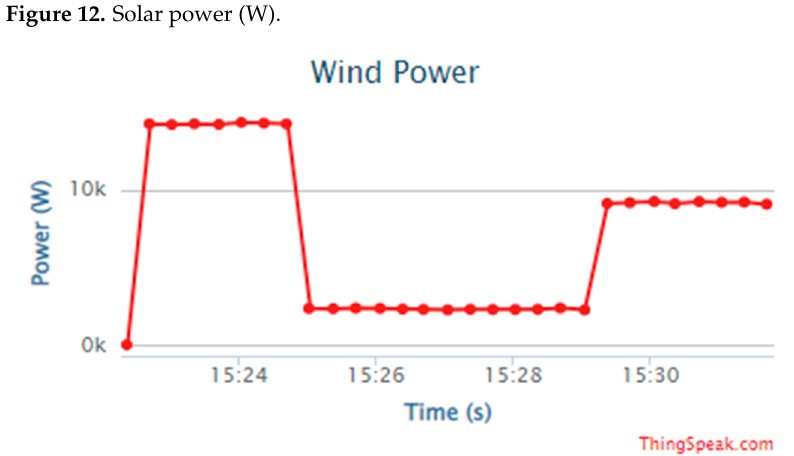
Figure 12. Solar power (W).